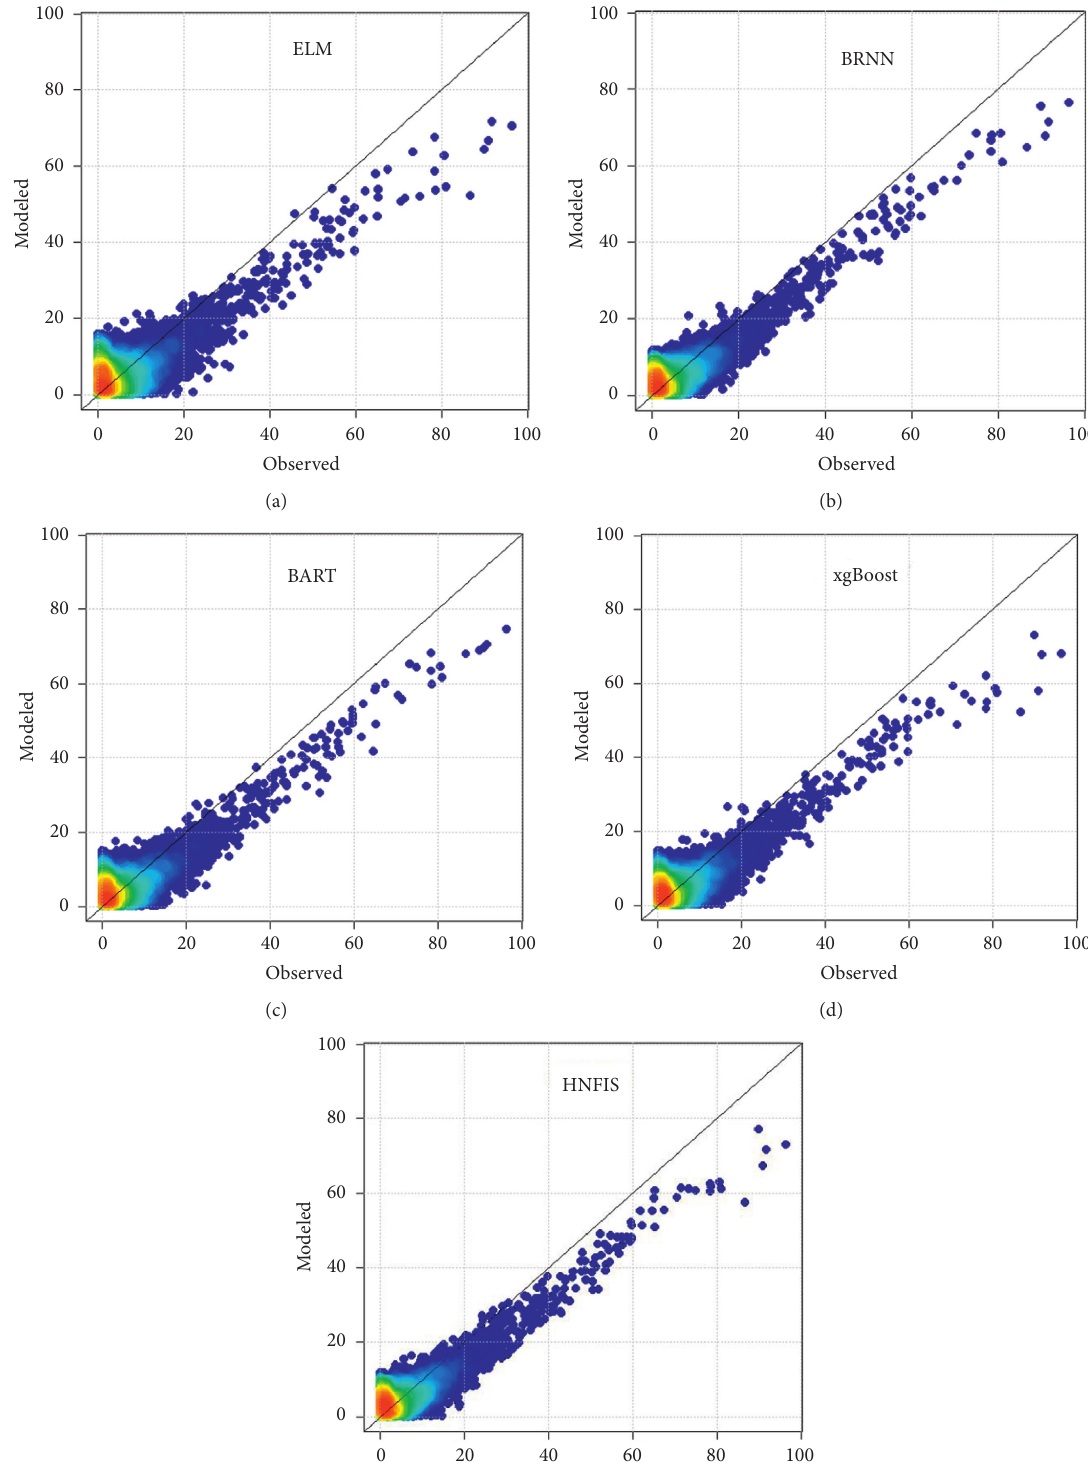
Figure 10: Comparison of observed and model simulated rainfall using density-scatter